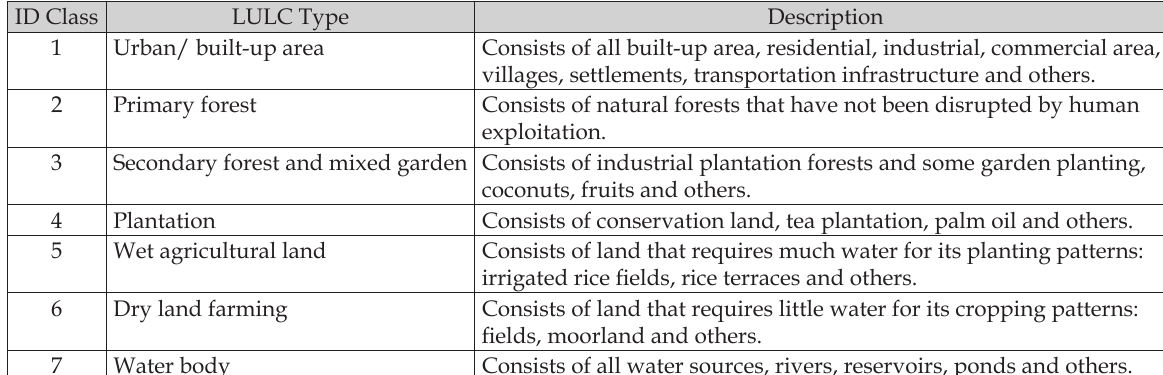
Table 1. LULC descriptions used in this study (sourced and modified from Yulianto et al. (2018, 2019). ID